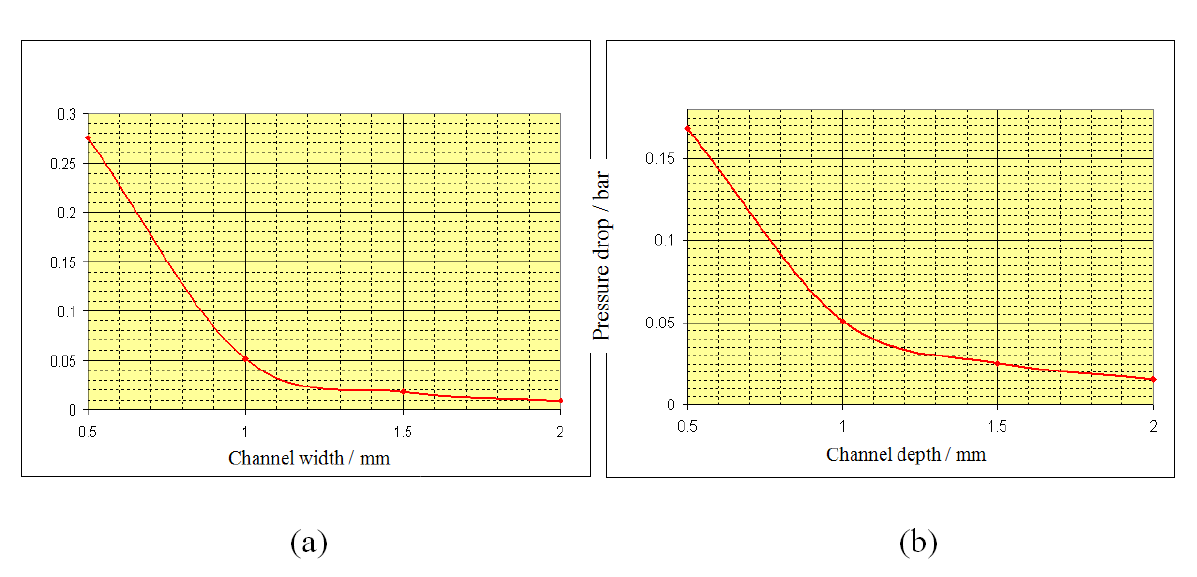
Figure 7. Pressure drop for cases varying channel width (a) and channel depth